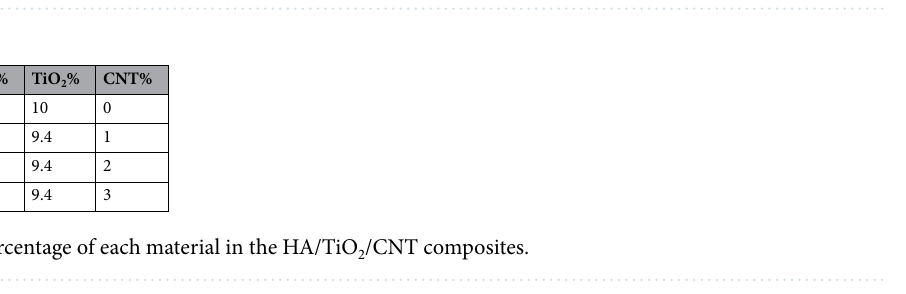
Figure 1. Schematic illustration of the process of synthesizing TiO 2 nanopowder.